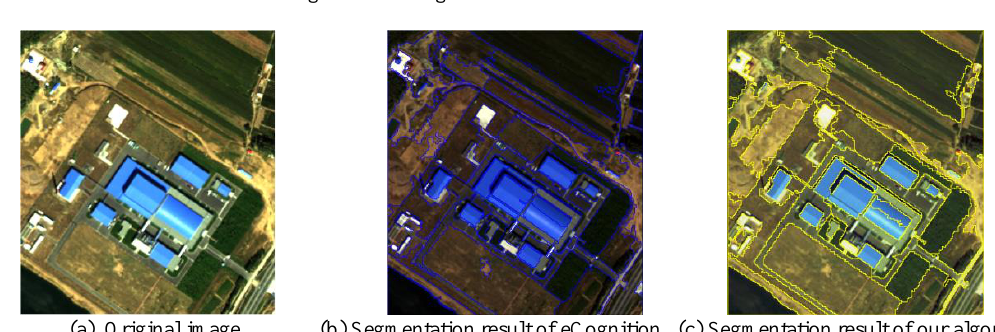
Figure 6. The segmentation result of water area